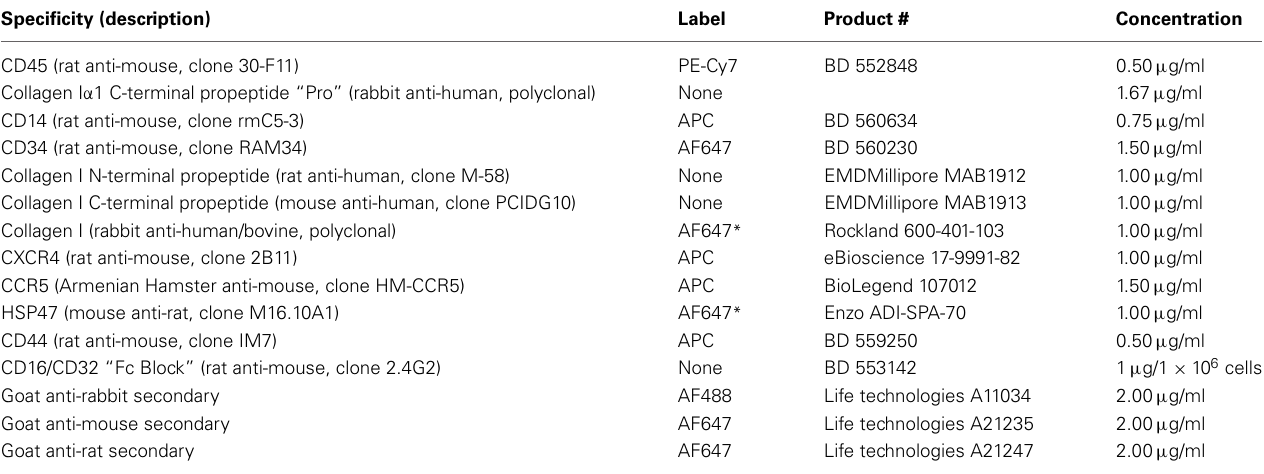
Table 1 | Antibodies used in flow cytometry